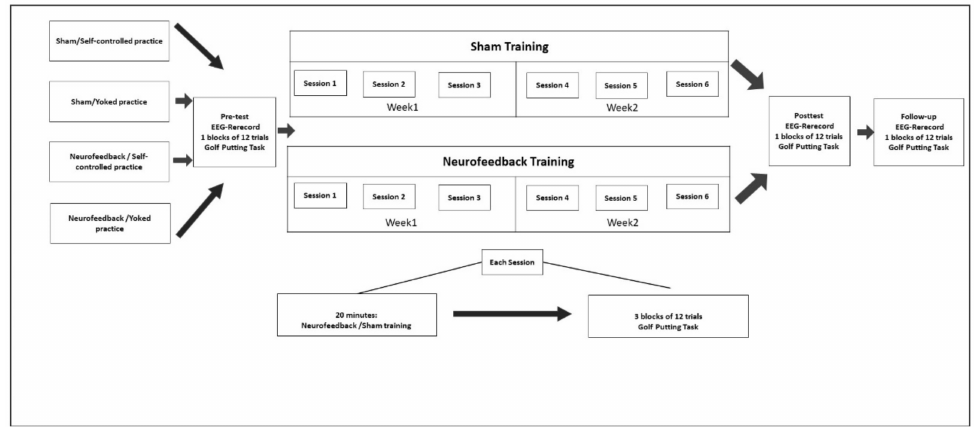
Figure 1. Experimental flowchart.